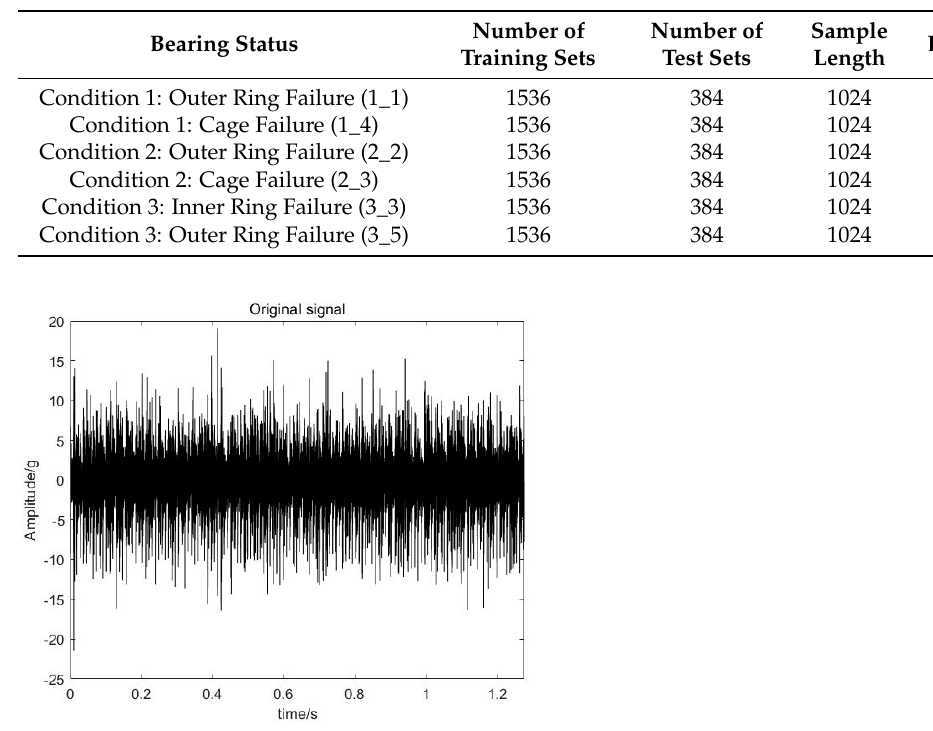
Figure 10. Original Signal Map.